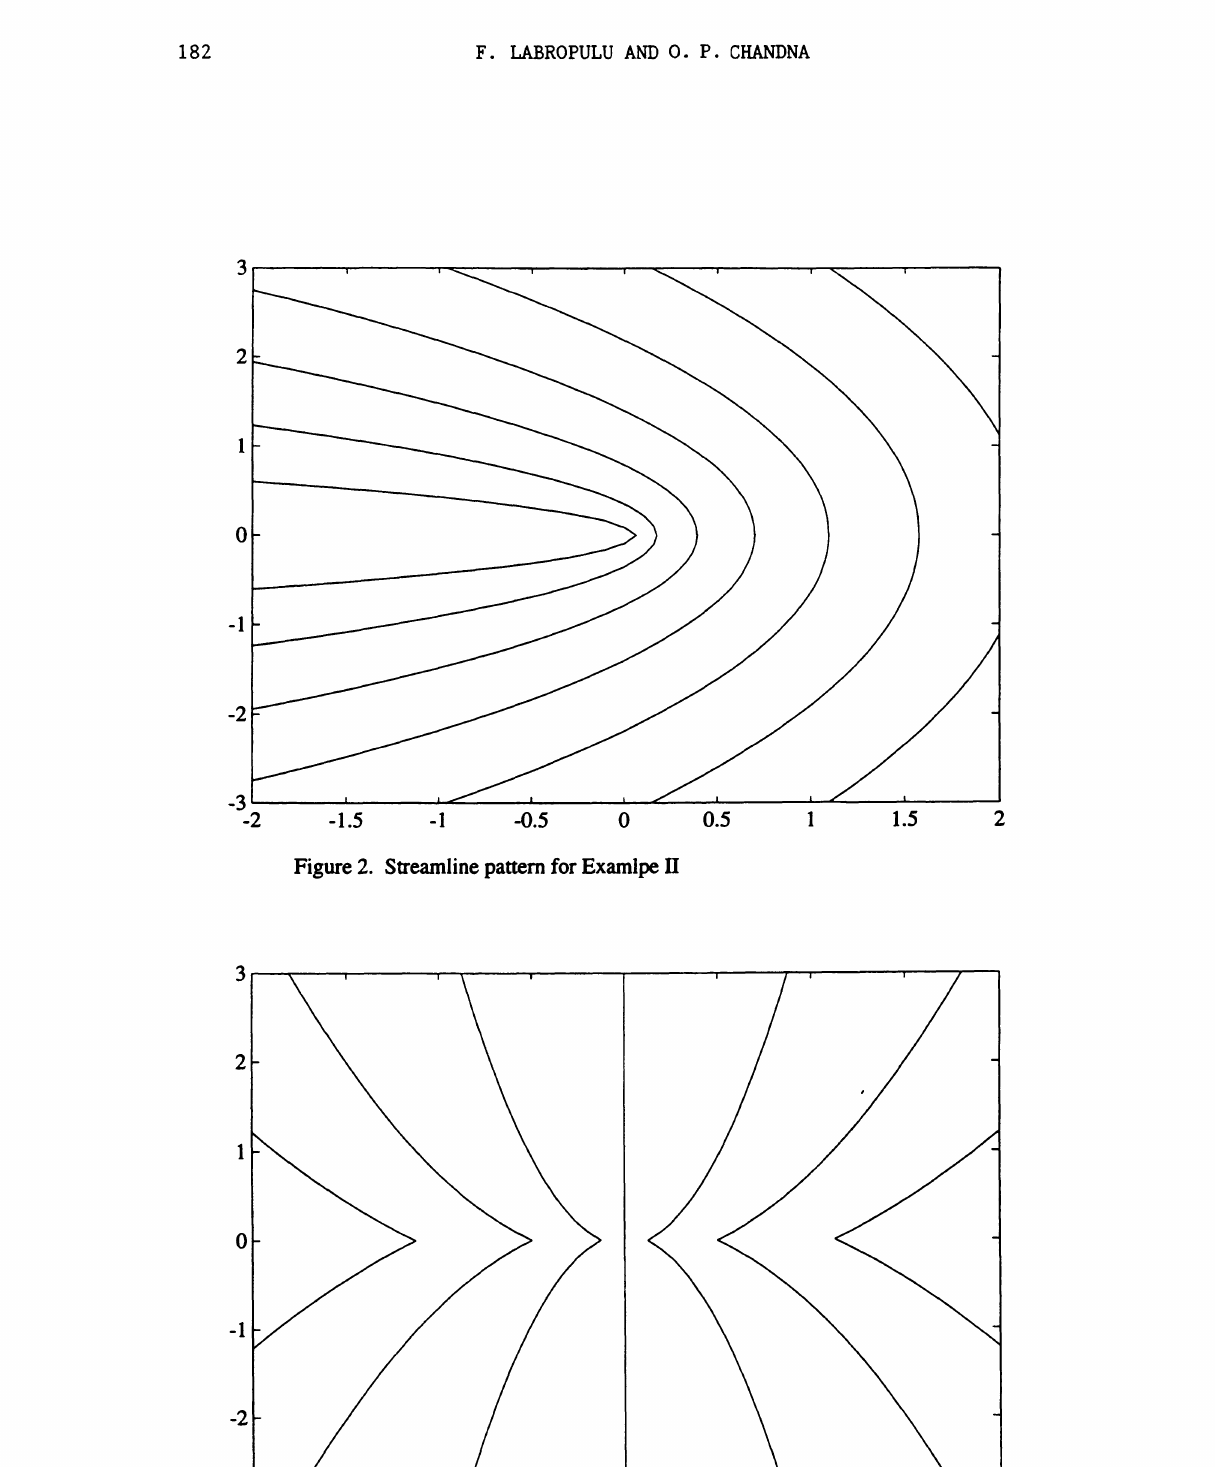
Figure 3. Streamline pattern for Examlpe